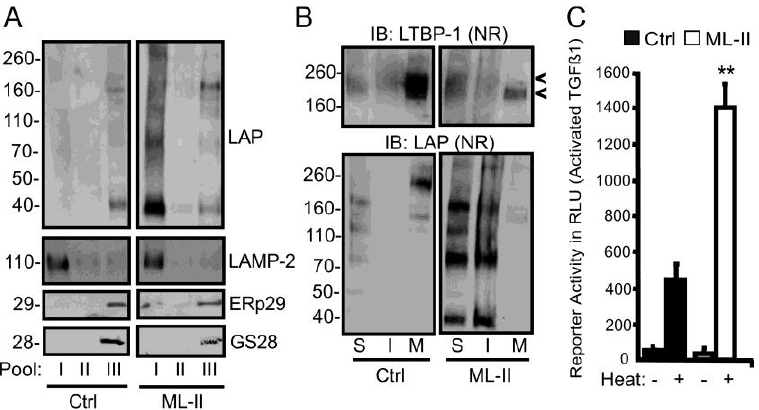
Figure 3. Increased intracellular latent TGF β 1 in ML-II fibroblasts is localized within dense, detergent-insoluble lysosomal fractions. ( A ) Western blot analysis of pooled Percoll gradient fractions from control and ML-II cellular lysates (n = 4). SDS-PAGE-resolved fractions were subjected to analysis using antibodies against markers for lysosomes (LAMP-2), Golgi (GS28) and ER (ERp29) as well as LAP. Pool I, dense membranes (lysosomes); pool II, intermediate density organelles; pool III, ER and Golgi membranes. ( B ) Western blots of human control and ML-II cells fractionated into deoxycholate (DOC)-soluble (S) and –insoluble (I) fractions (n = 4). Along with concentrated media (M) fractions, these pools were resolved by non-reducing (NR) SDS-PAGE and immunoblotted with antibodies against human LAP or LTBP-1. The upper and lower arrowheads indicate the position of the LLC and free LTBP-1, respectively ( C ) Luciferase assays (n = 3) of heat-treated deoxycholate-insoluble fractions that were applied to mink lung TGF β 1 reporter cells; luciferase activity was measured in relative luminescence units, ** p < 0.01.